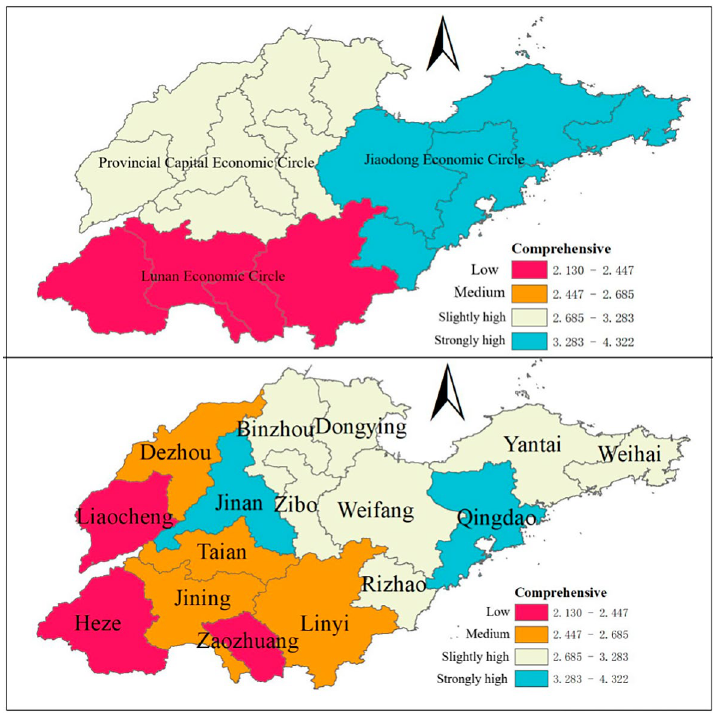
Figure 1. Comprehensive construction level indicators of new SCCs in Shandong